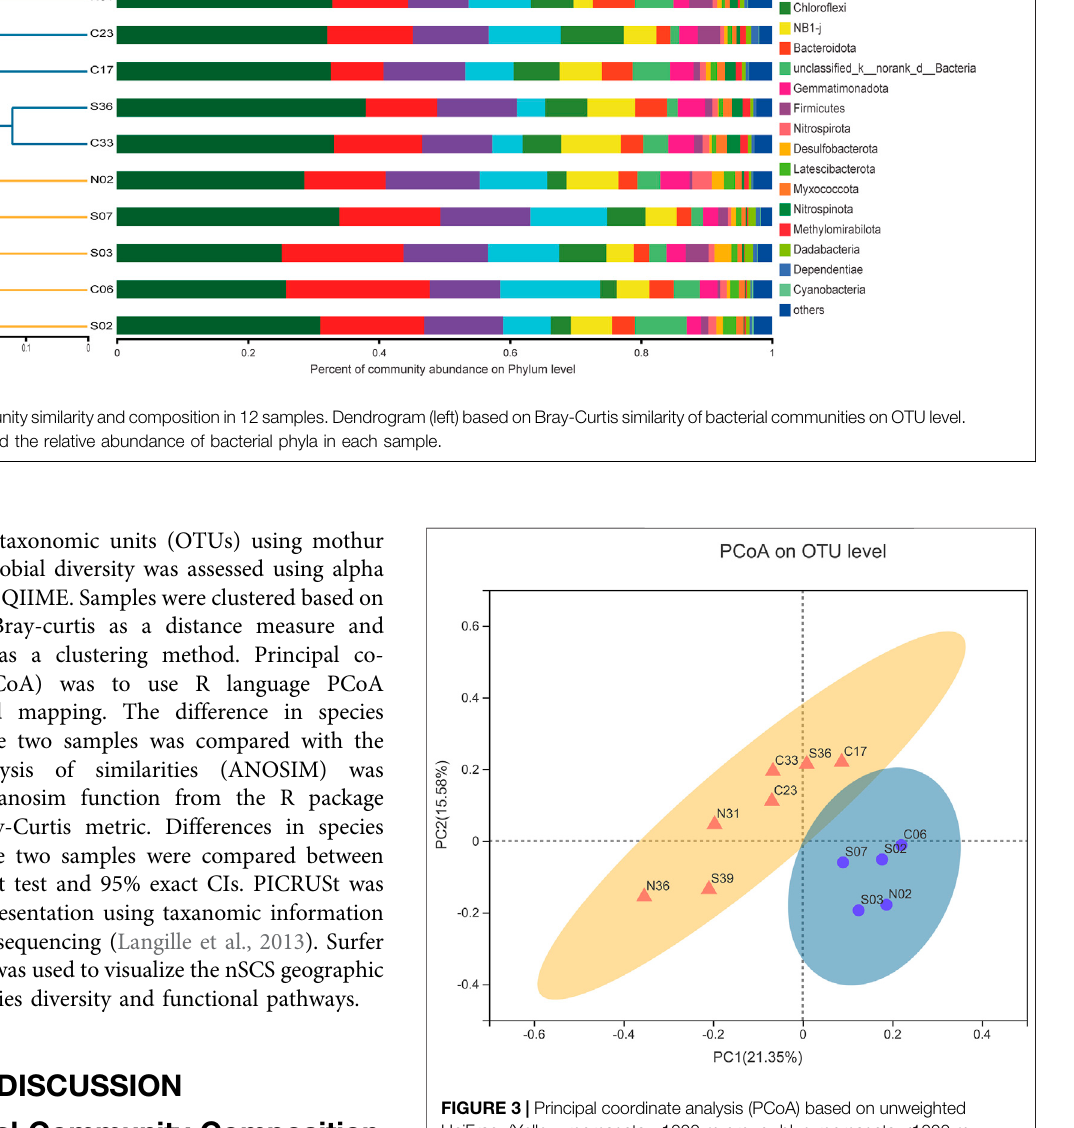
FIGURE 3 | Principal coordinate analysis (PCoA) based on unweighted UniFrac. (Yellow represents > 1000 m group, blue represents ≤ 1000 m